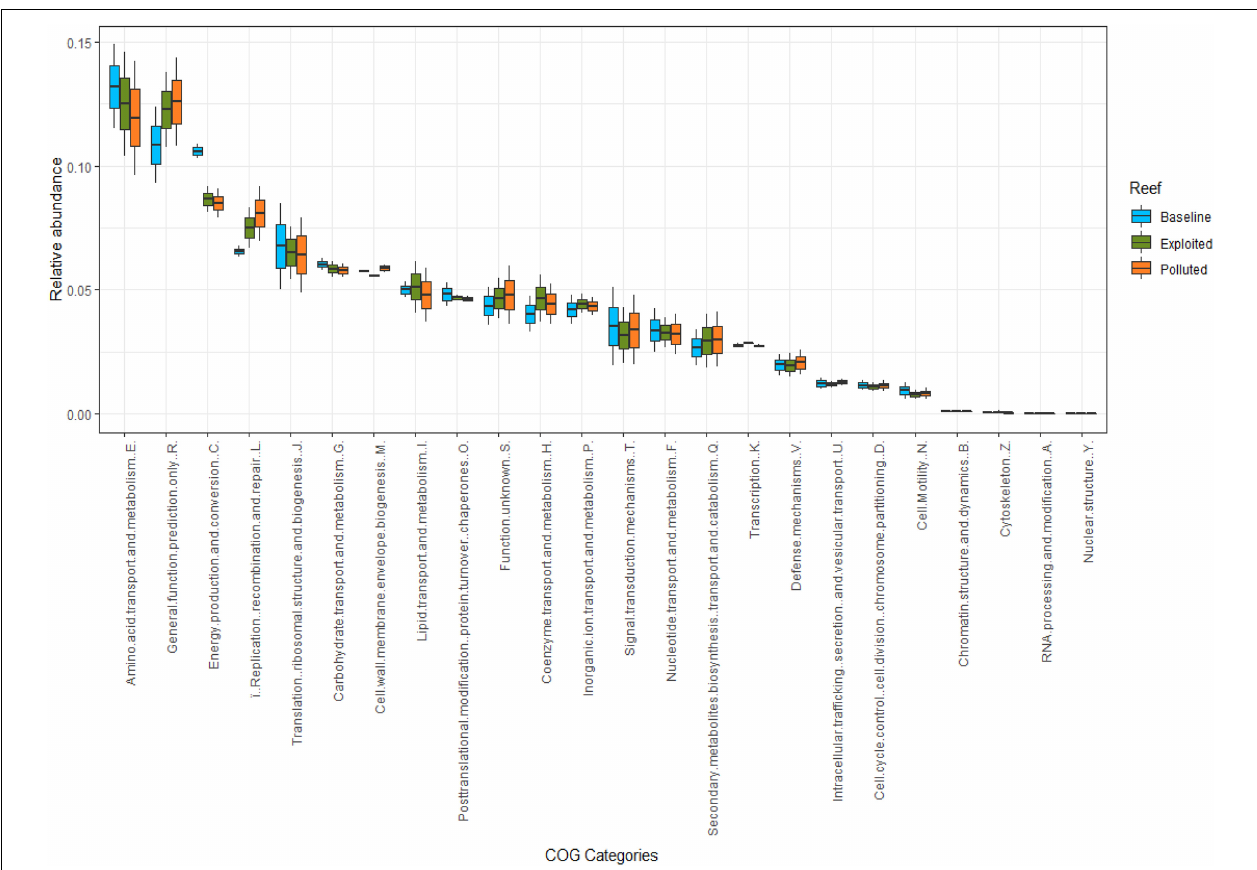
FIGURE 6 | Relative abundances of COG functional categories compared between study sites i.e., “baseline” (sky blue), “exploited” (olive), and “polluted”